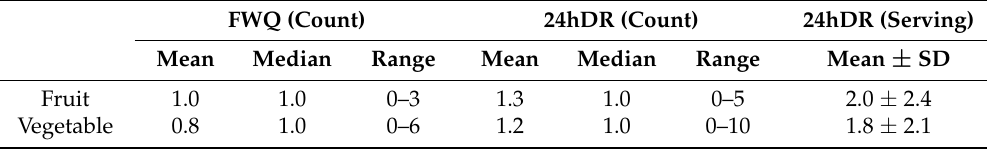
Table 1. Fruit and vegetable consumption among participants measured by the FWQ and 24hDR ( n = 82). FWQ (Count) 24hDR (Count) 24hDR (Serving) Mean Median Range Mean Median Range Mean ± SD Fruit 1.0 1.0 0–3 Vegetable